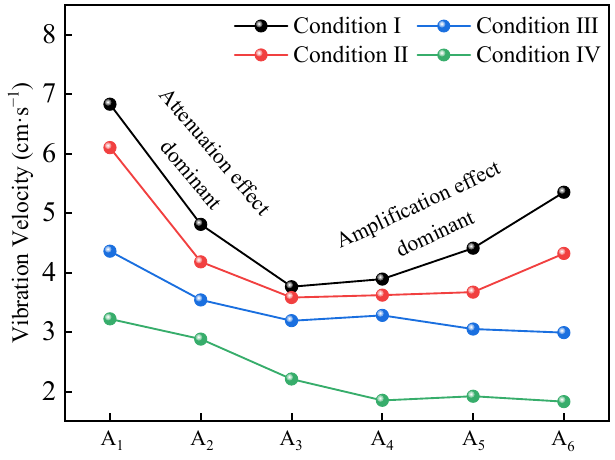
Figure 8. The vibration variation curve of the slope.